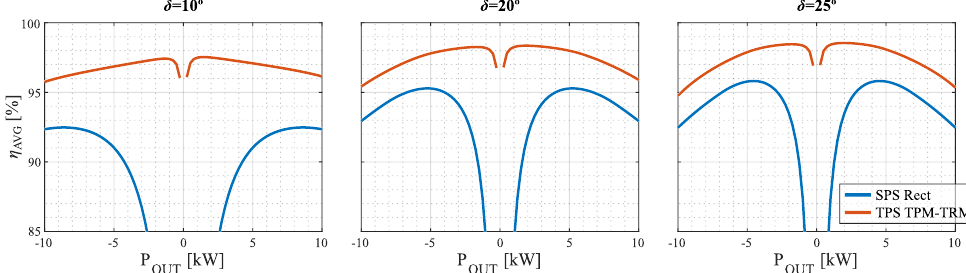
Figure 7. Efficiency versus output power ( P OUT ) in SPS rectangular and combined TPS TPM − TRM modulations for the considered δ lim : 10 ◦ , 20 ◦ and 25 ◦ .